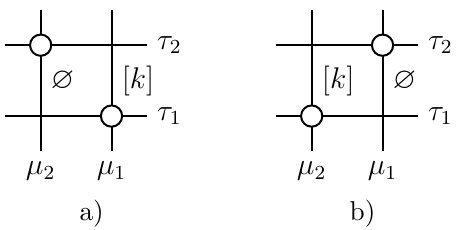
Figure 1 . Two toric CY diagrams corresponding to two vacua of the 3 d FT [SU(2)] theory. Notice that the spectral parameters of external legs are the same in both